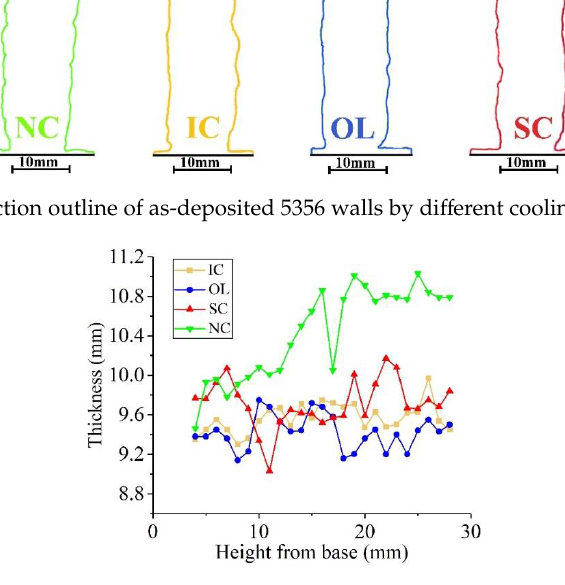
Figure 8. Thickness of as-deposited walls in the direction of height deposited by different cooling processes.